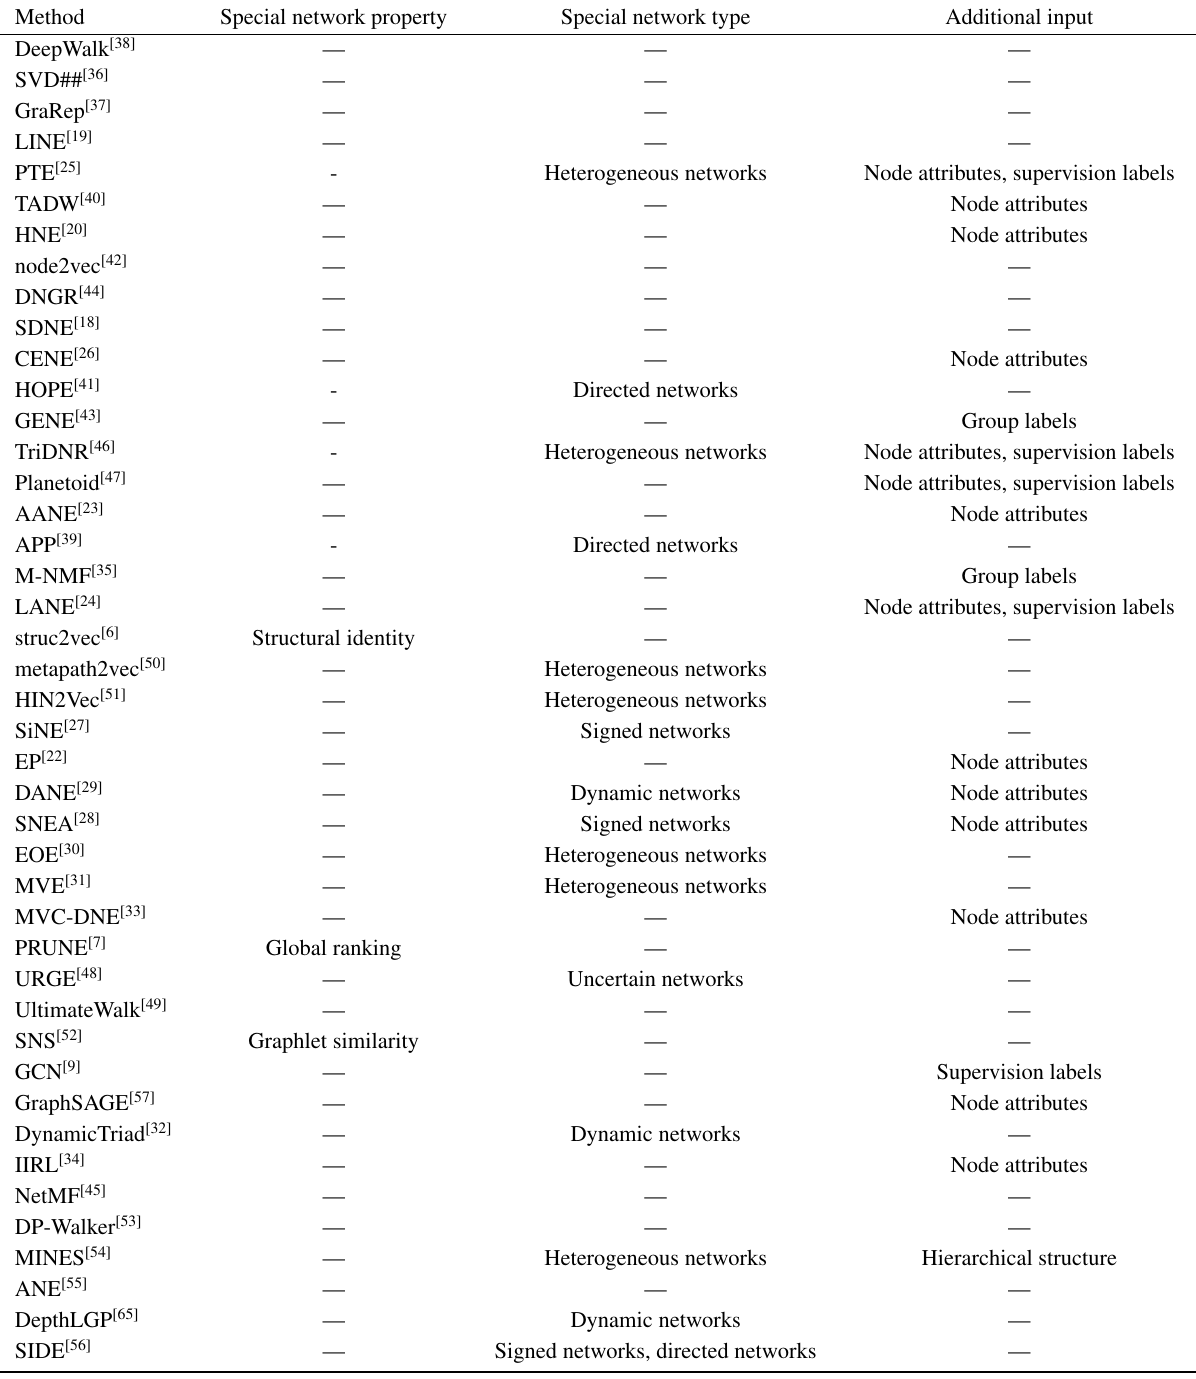
Table 2 Non-technical taxonomy of network embedding